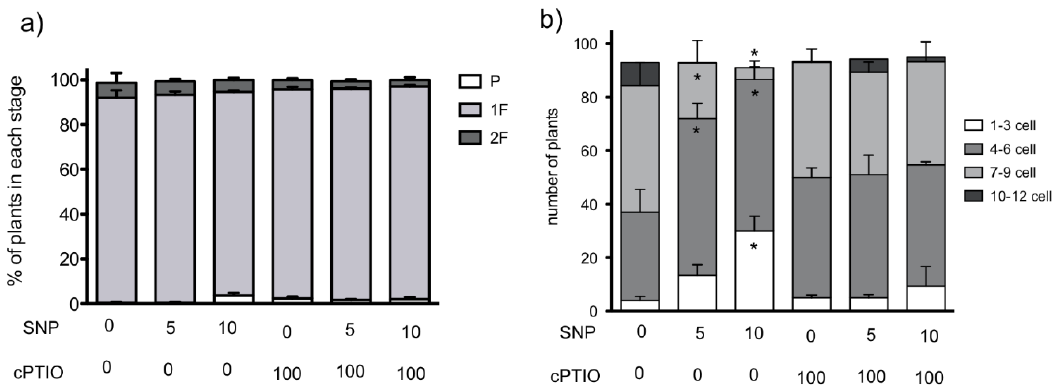
Figure 3. Effect of NO donors in young plant development. Isolated protoplasts were allowed to develop into plants for four days before starting the treatments with NO donor sodium nitroprusside (SNP) and/or scavenger 2-(4-carboxyphenyl)-4,4,5,5-tetramethylimidazoline-1-oxyde-oxyl-3-oxyde (cPTIO) at different concentrations in µM. Treatments lasted five days. ( a ) Percentage of plants in each development state at 10 days after isolation (DAI) and five days under treatment. ( b ) The number of cells in the plants in one filament (1F) stage in ( a ) were counted and compared between treatments. Four groups were formed: filaments with 1 to 3, 4 to 6, 7 to 9 and 10 to 12 cells/filament. Three independent experiments were analyzed by one-way ANOVA and Tukey´s multiple comparison test. Asterisks indicate statistical differences with control at p < 0.05.